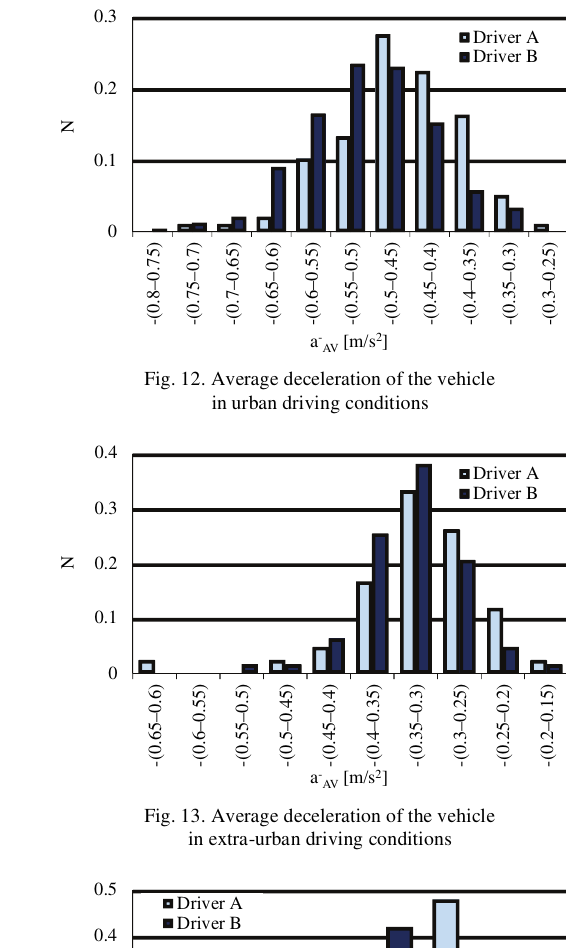
Fig. 13. Average deceleration of the vehicle in extra-urban driving conditions